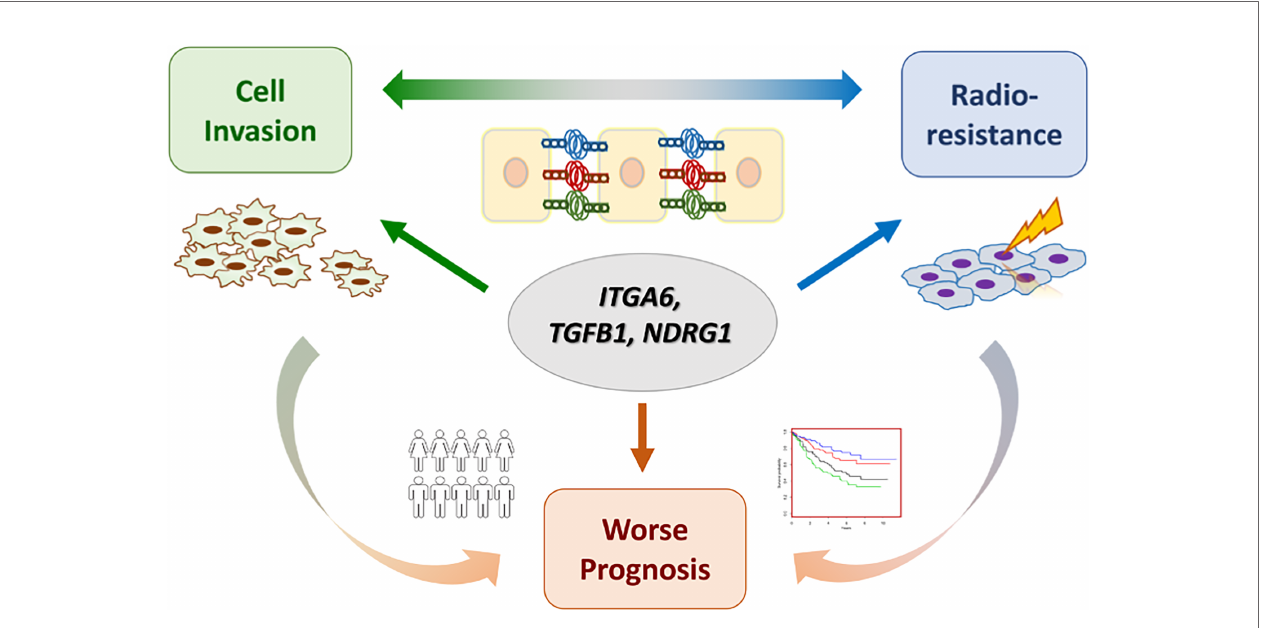
FIGURE 7 | A model of molecular crosstalk between cell invasion and radioresistance in